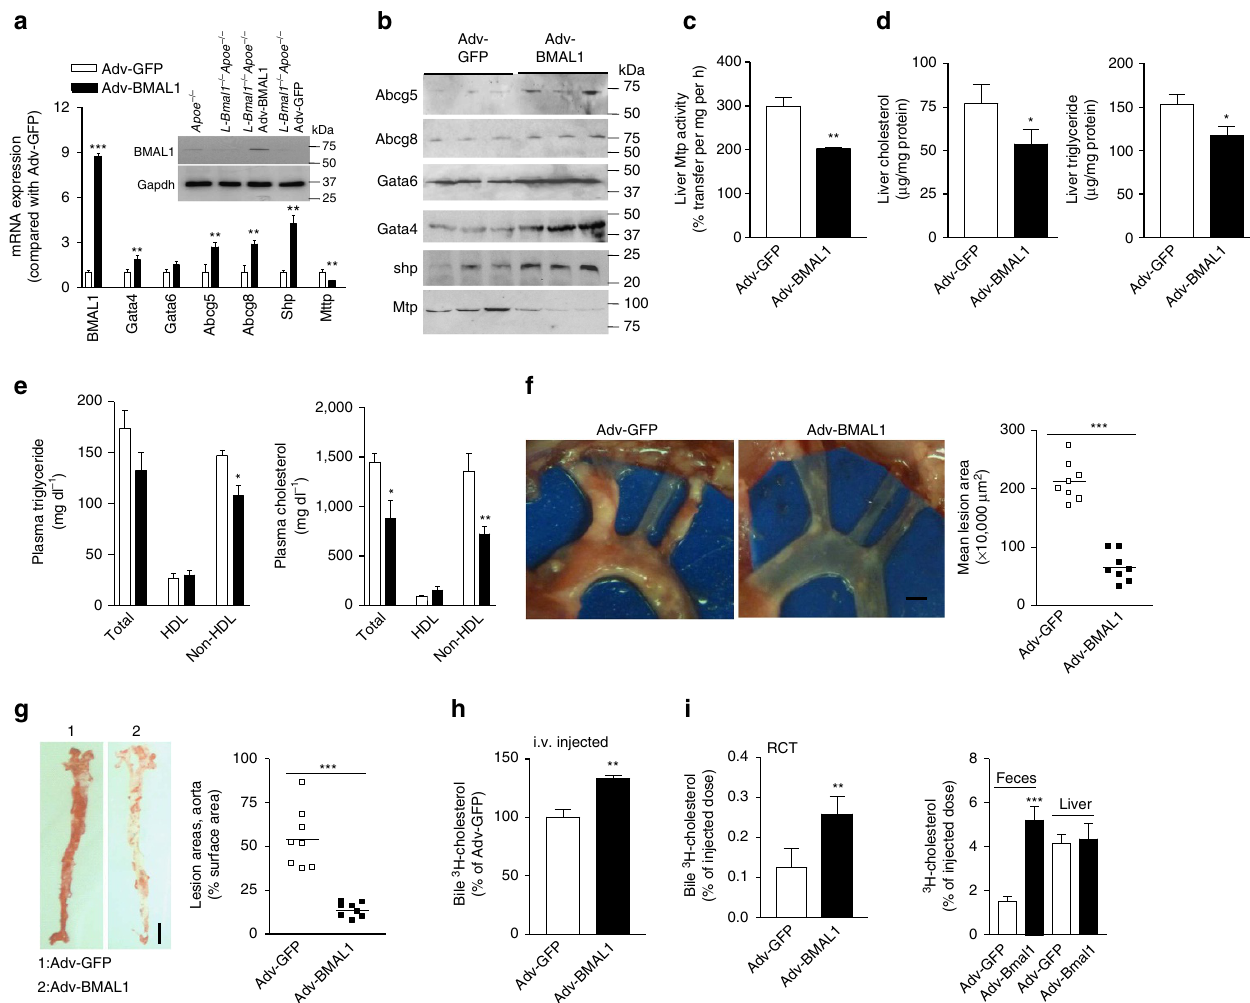
Figure 4 | Effects of Bmal1 expression in L-Bmal1 (cid:2) / (cid:2) Apoe (cid:2) / (cid:2) mice. L-Bmal1 (cid:2) / (cid:2) Apoe (cid:2) / (cid:2) mice (3 months, male) were transduced with 1.5 (cid:3) 10 11 virus particles of either Adv-BMAL1 (black square) or Adv-GFP (white square) and started on a Western diet. After 4 weeks, plasma and tissues were collected for analysis. ( a ) mRNA levels of different indicated genes were quantified. Inset shows Bmal1 protein in the livers of different mice. ( b ) Different proteins were detected in the livers of L-Bmal1 (cid:2) / (cid:2) Apoe (cid:2) / (cid:2) mice transduced with Adv-BMAL1 or Adv-GFP. ( c , d ) Hepatic MTP activity ( c ), cholesterol and triglyceride ( d ) were measured. ( e ) Plasma triglyceride and cholesterol were measured in total plasma and different lipoprotein fractions after separation by precipitation. ( f ) Aortic arches were dissected, photographed (left) and lesions areas were quantified (right). Scale bar, 2mm. ( g ) Aortas were stained with Oil Red O (left) and quantified (right). Scale bar, 5mm. ( h ) Amounts of cholesterol excreted to bile after intravenous injection ( n ¼ 4 per group). ( i ) Amounts of cholesterol in the bile, feces, liver and plasma 48h after placing 3 H-cholesterol-loaded J774 macrophages in the peritoneal cavity of different mice ( n ¼ 4 per group). Data in a , c–e , h and i were evaluated using the unpaired Student’s t -test. Data in e and f were tested using one-way ANOVA. Values are mean ± s.d., n ¼ 8 per group. * P o 0.05, ** P o 0.01, and *** P o 0.001. Error bars represent